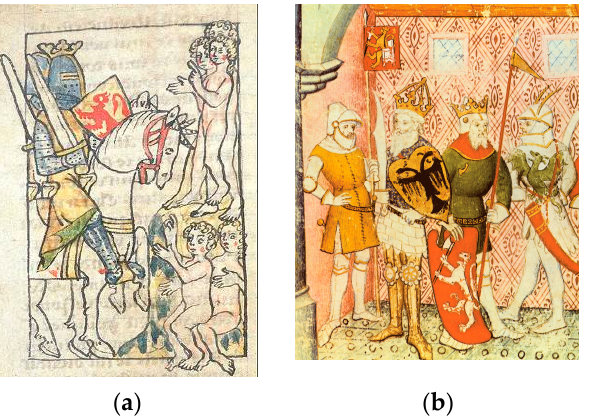
Figure 5. ( a ) Alexander from Le roman de toute chevalerie ; ( b )Alexander as a part of the three good pagans from Nine Worthies, Le Chevalier Errant